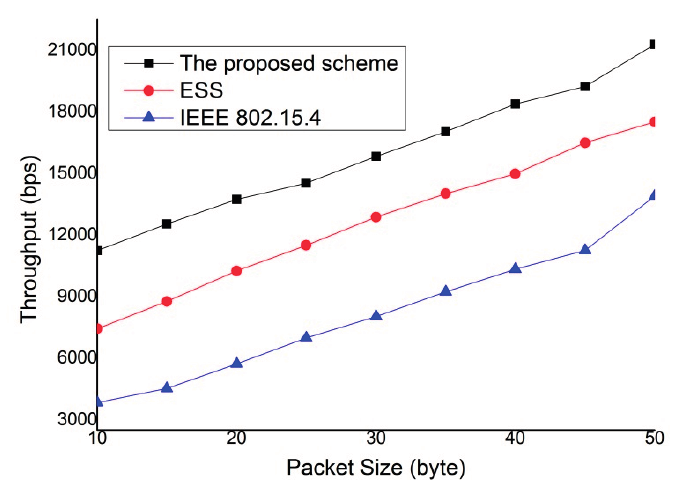
Figure 13. Throughput comparison.